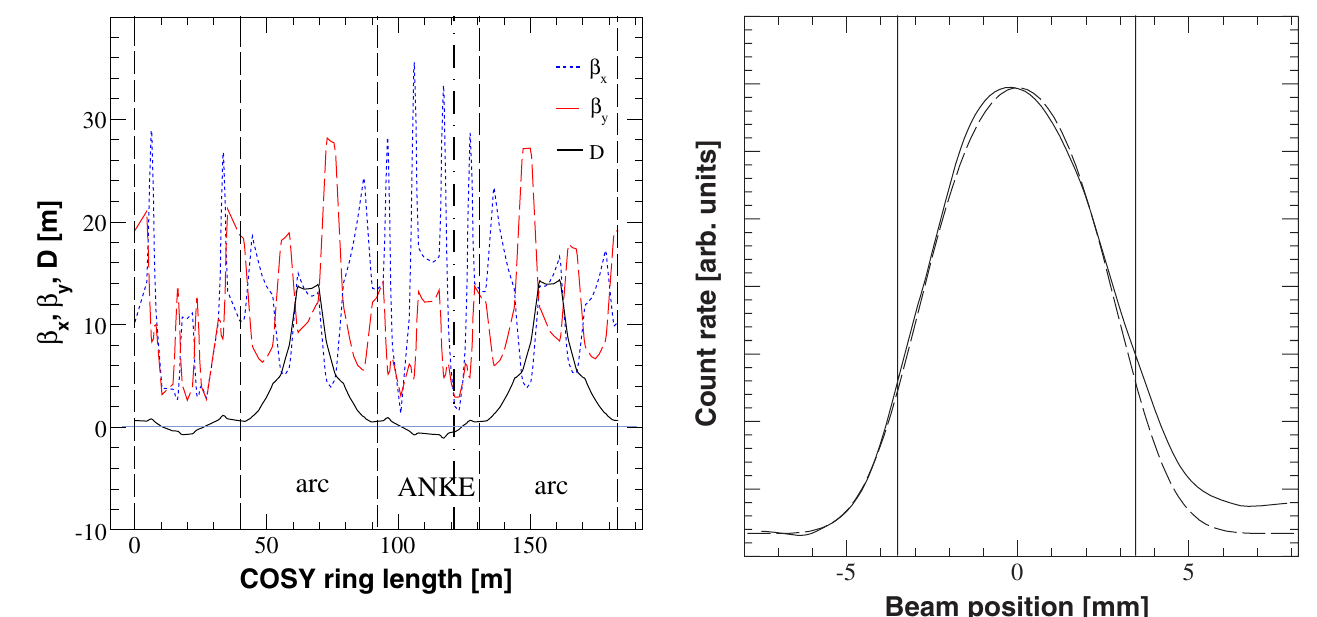
FIG. 2. (Color) Ion optical functions around the COSY ring as adjusted for experiments at ANKE. Here (cid:4) (dashed line) are the horizontal and vertical beta functions, and D (solid line) is the dispersion.